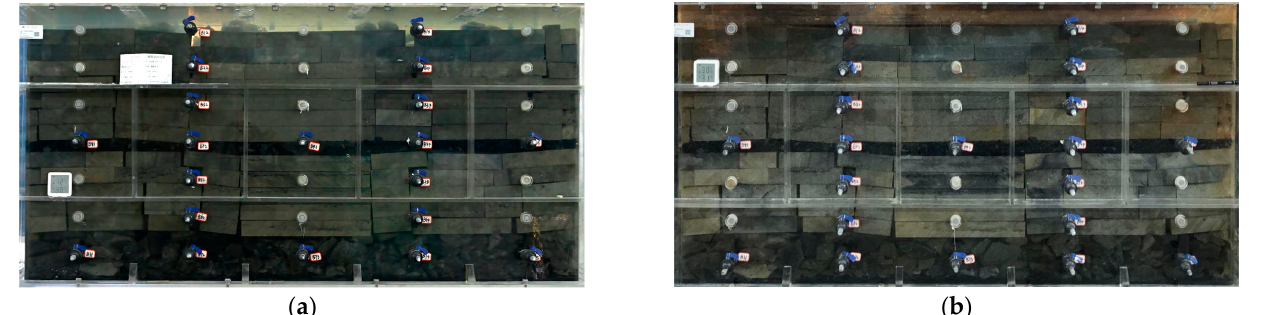
Figure 9. Color change of goaf water. ( a ) was taken on the 30th day of the experiment, and ( b ) was taken on the 300th day.